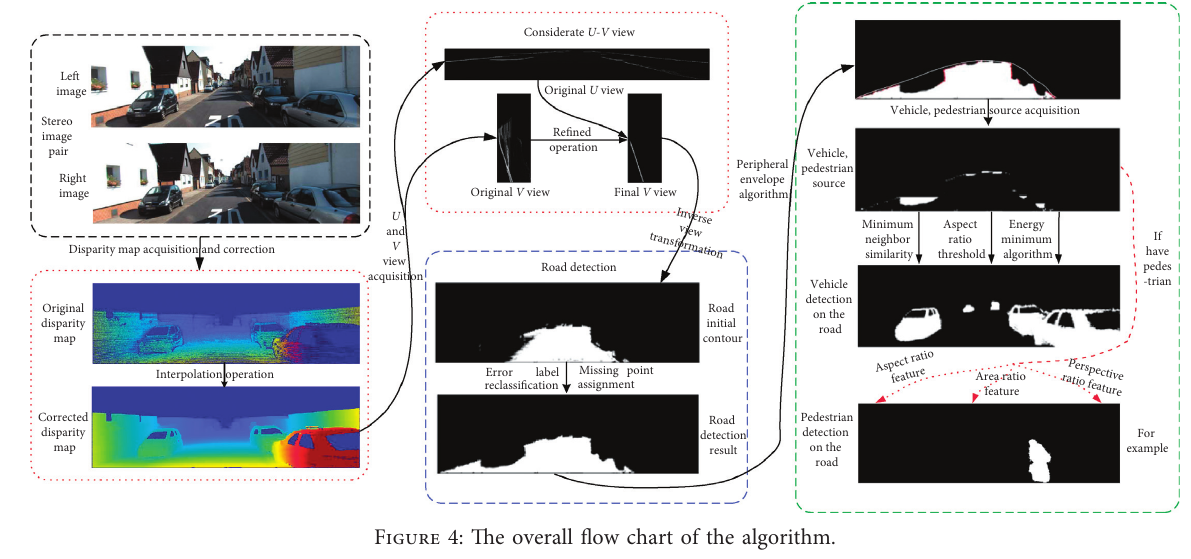
Figure 4: The overall flow chart of the algorithm.